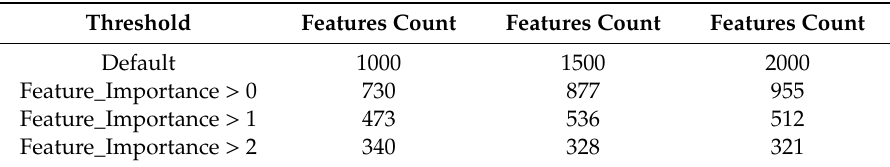
Table 9. Number of selected features using feature